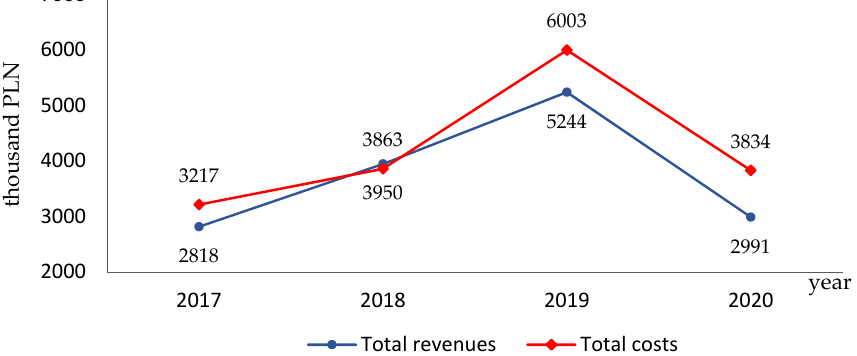
Figure 4. Total revenues and total costs in the enterprise in 2017–2020 (thousand PLN).